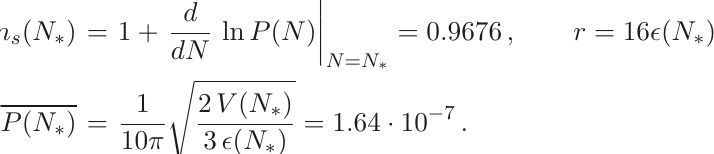
in GeV units from horizon exit to the final settling into the global 3 / 2